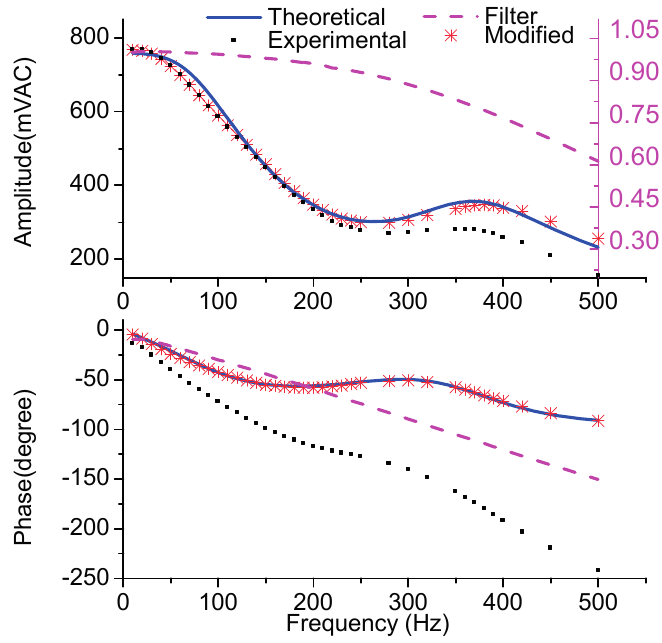
Figure 16. The measured frequency response and the theoretical frequency response of the micro-gyroscope.